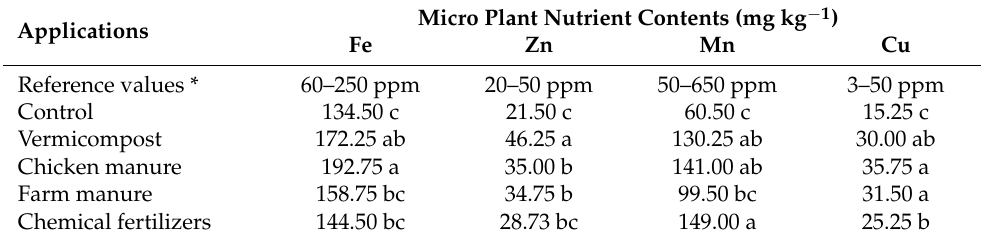
Table 8. Effects of fertilizer applications on micronutrient contents in the leaves.